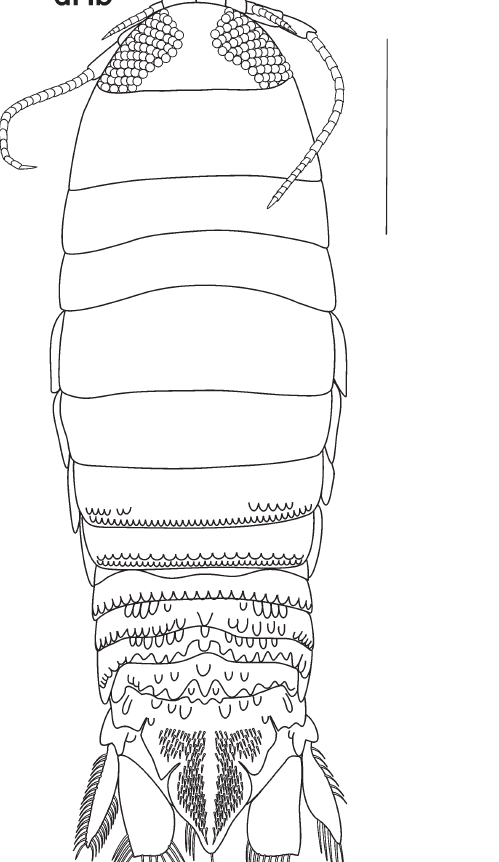
Figure 3. Excorallana costata Lemos de Castro, 1960. Male, 12 mm. (MOUFPE 957), habitus and frontal lamina. Scale = 2 mm